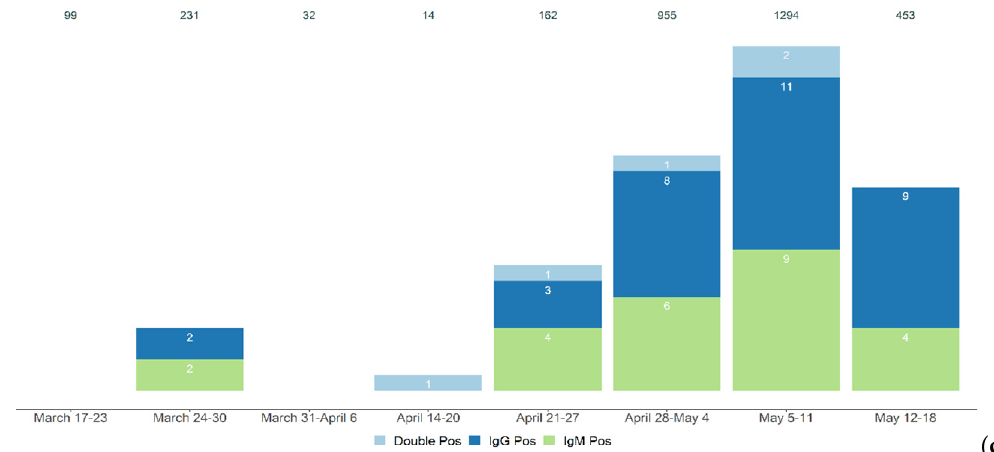
Figure 4. Time-lapse of healthcare seropositivity at Foggia Hospital” “Policlinico Riuniti” during the COVID-19 outbreak and lockdown (17 March to 18 May 2020). IgG ( a ) and IgM ( b ) seroprevalence stratified by weekly time points. Ig values are expressed as log10 of the original concentration (AU/mL). Cut-off was set at 8 AU/mL (log 10 (8) = 0.9). ( c ) Number of COVID-19-positive healthcare workers by weeks of enrollment.